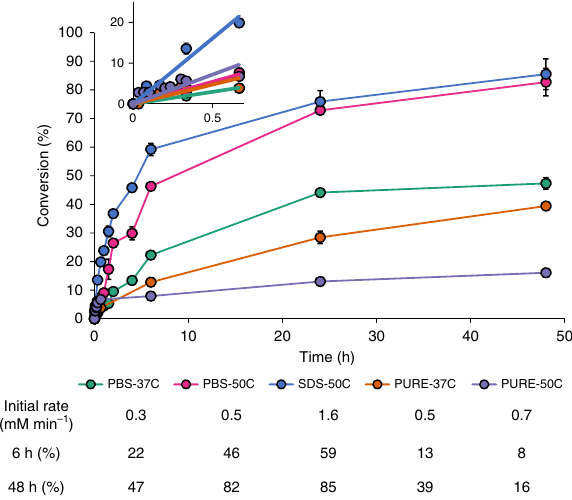
Fig. 4 Modi fi ed encapsulation of LsLAI maximizes tagatose production. Batch tagatose production over time starting from 300 mM